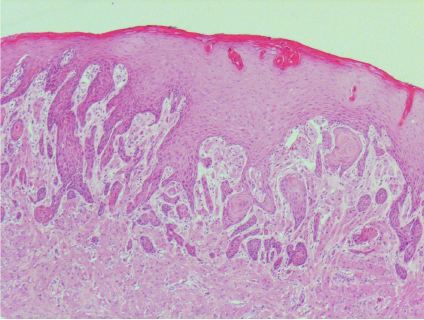
Figure 2: Low power view of oral granular cell tumour stained with hematoxylin and eosin.